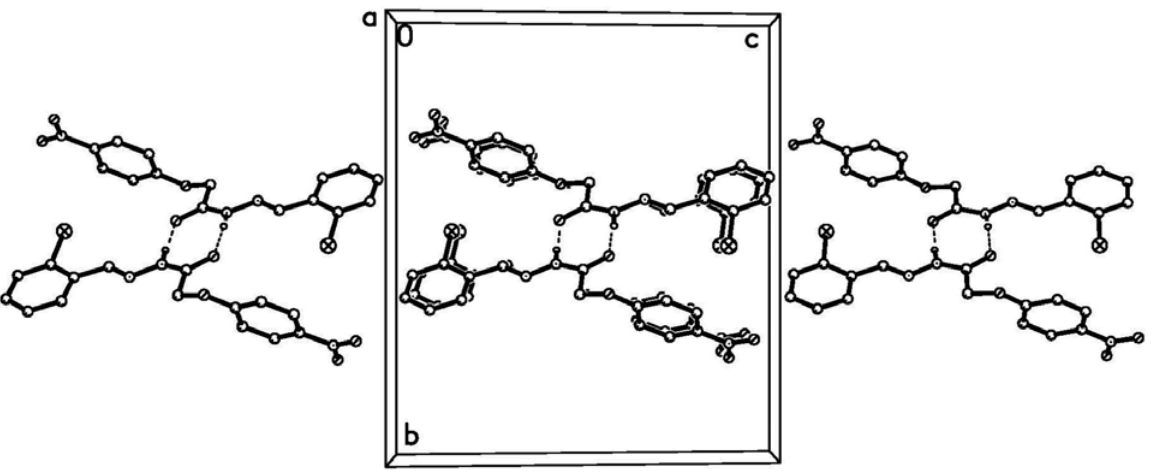
Figure 3. Molecular packing diagram of 1 . Hydrogen bonds are shown as dashed